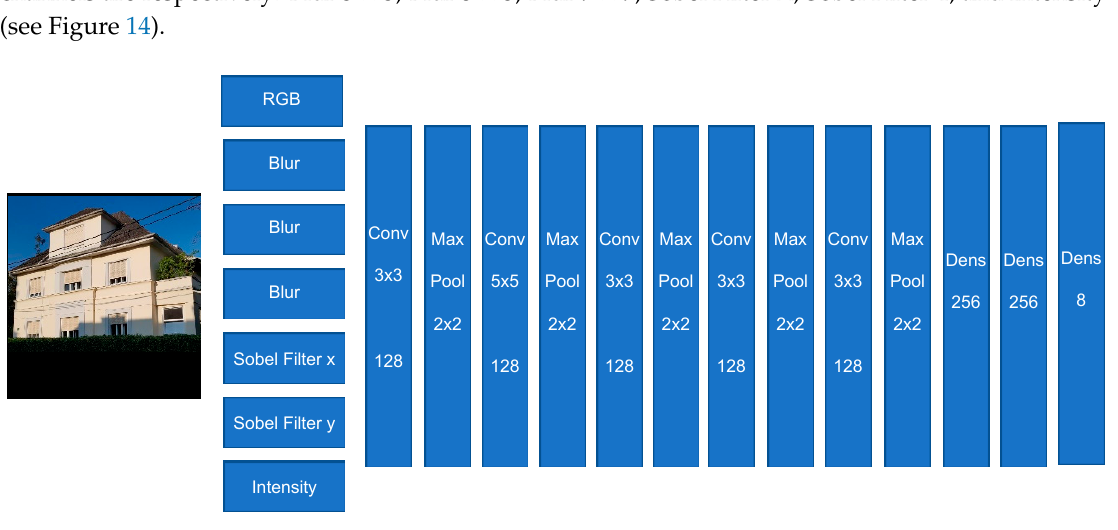
Figure 14. The house classification Model II (Source of input image: our own image).